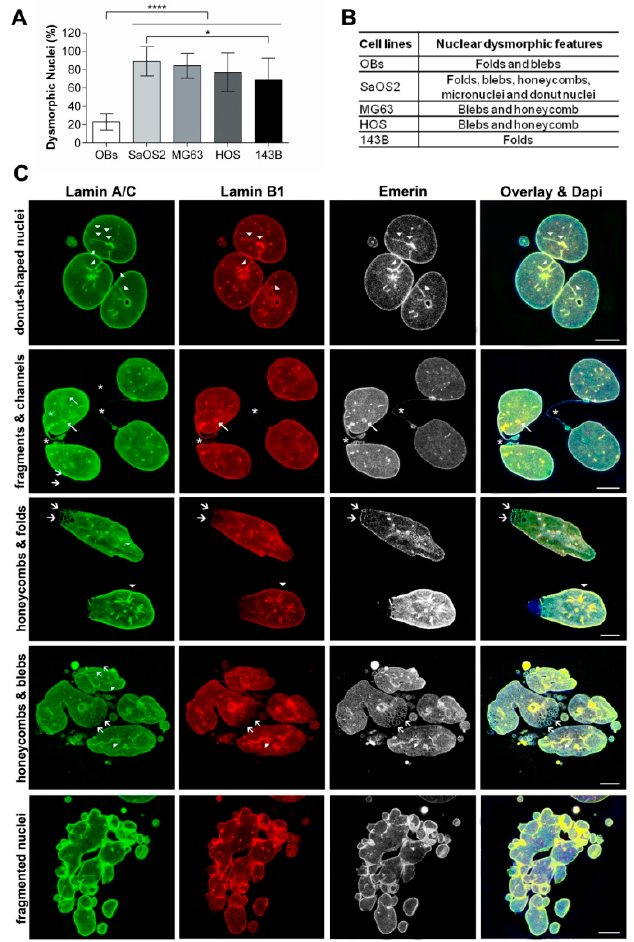
Figure 1. ( A ) Relative percentage of abnormal nuclei observed in osteoblasts (OBs) and osteosarcoma (SaOS2, MG63, HOS and 143B) cell lines. * p < 0.05; **** p < 0.001. ( B ) Morphological features of nuclear dysmorphisms such as folds, honeycombs, fragmented, lobulated (blebs) and donut nuclei, are differentially observed in each cell line. ( C ) Morphological aspects of SaOS2’s nuclear envelope / lamina exhibiting dysmorphic features resembling those of laminopathic nuclei highlighted by multiple labeling with lamin A / C (green), lamin B1 (red) and emerin (white) antibodies. Donut-shaped nuclei (first lane), nuclei with folds (arrowheads, first and third lanes) and channels (second lane, arrow) micronuclei and fragmented NEs (second lane, asterisk; fourth and fifth lanes) are shown. Further lamin A / C and emerin meshworks lacking lamin B1 (honeycombs, third and fourth lanes, arrows) are also observed. Nuclei were stained with Dapi. Bars: 10 µ